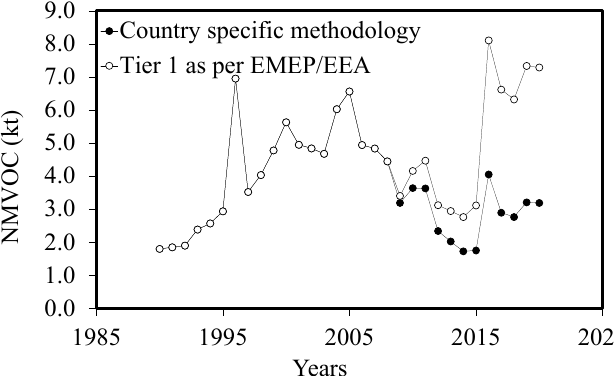
Figure 4. NMVOCs emissions from printing.